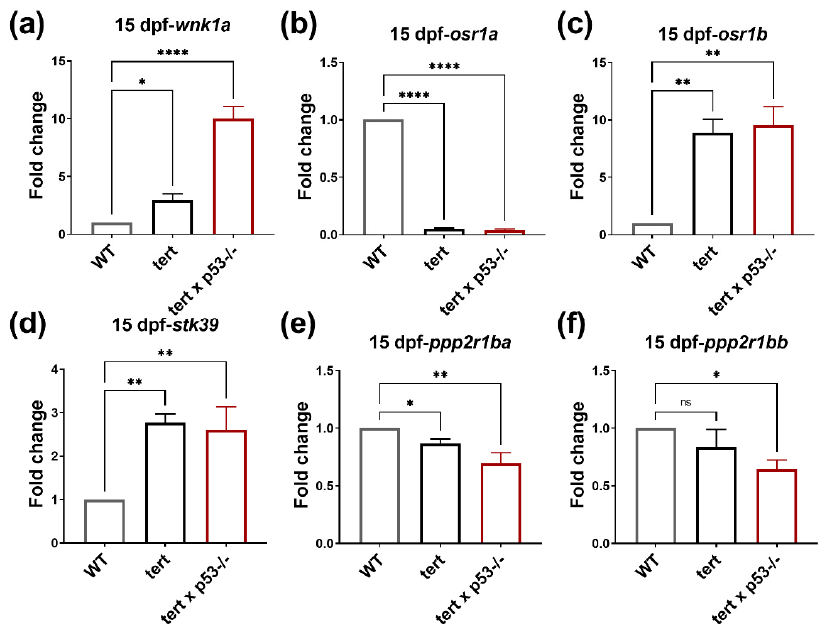
Figure 6. Upregulated wnk1a , stk39 , and osr1b , and downregulated ppp2r1ba and ppp2r1bb in 15 dpf [ tert ] and [ tert x p53 − / − ] transgenic fish. The expression of wnk1a and its downstream effectors in WT, [ tert ], and [ tert x p53 − / − ] fish at 15 dpf. ( a ) wnk1a , ( b ) osr1a , ( c ) osr1b , ( d ) stk39 , ( e ) ppp2r1ba , and ( f ) ppp2r1bb in 15 dpf [ tert ] and [ tert x p53 − / − ] transgenic fish compared to WT. We performed three replicates, and for each qPCR, there were triplicates for each sample. Ten larvae were included in each experiment. One-way ANOVA analysis followed by multiple analysis was used to identify the statistical significance between groups. *: p ≦ 0.05; **: p ≦ 0.01; ****: p ≦ 0.0001; ns: no-significance.